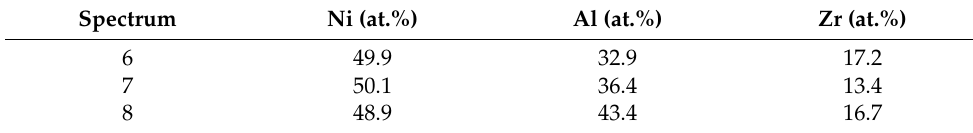
Table 8. Chemical composition of the analyzed region marked in Figure